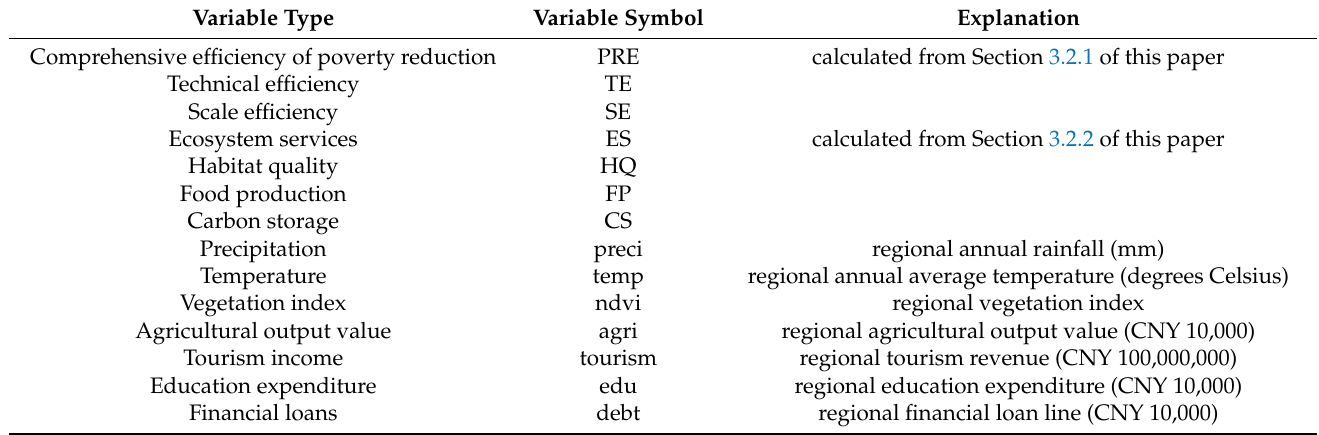
Table 2. Selection and description of